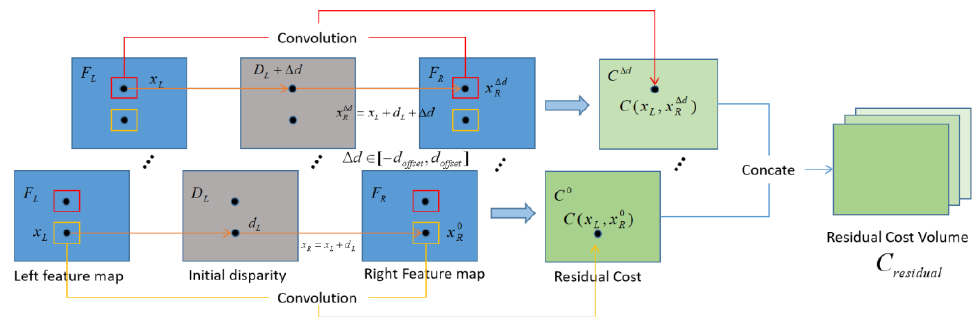
Figure 2. Construction process of the residual cost volume. The red and yellow boxes represent context windows of different points.